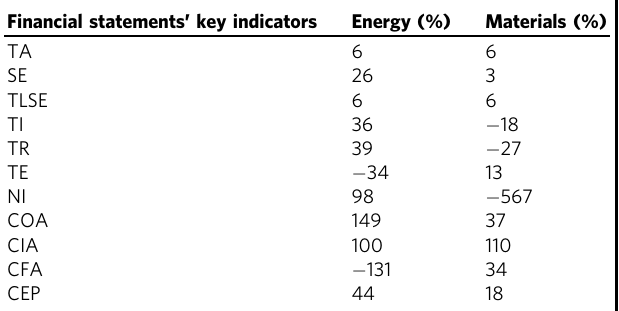
Figure 6 re fl ects the variance in mean and ST.d between key fi